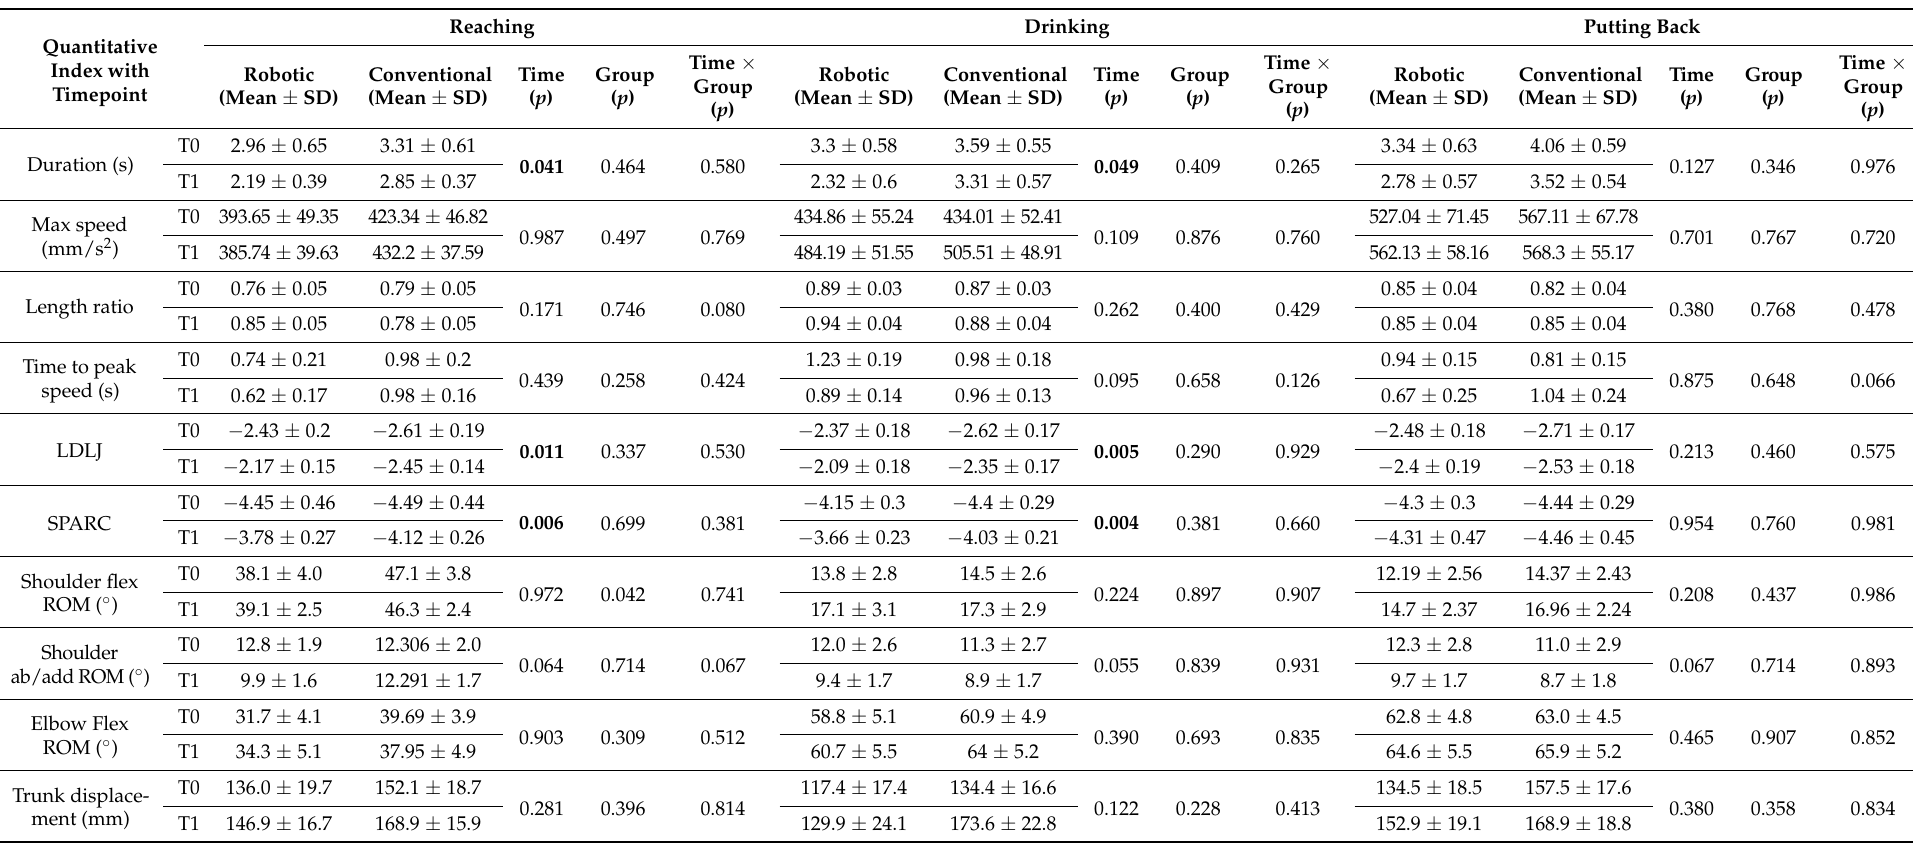
Table 4. Quantitative indices related to the investigated drinking task, for the two groups and the three phases, separately. p -values lower than 0.05 are highlighted in